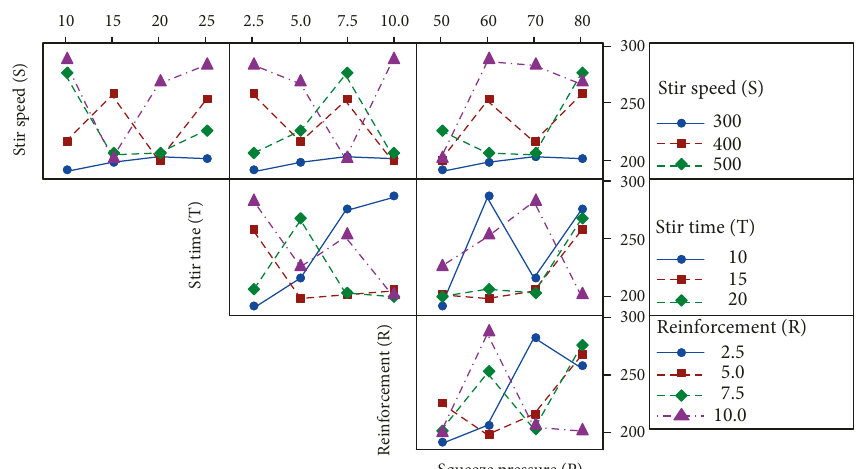
Figure 12: Interaction plot for tensile strength between the input parameters.